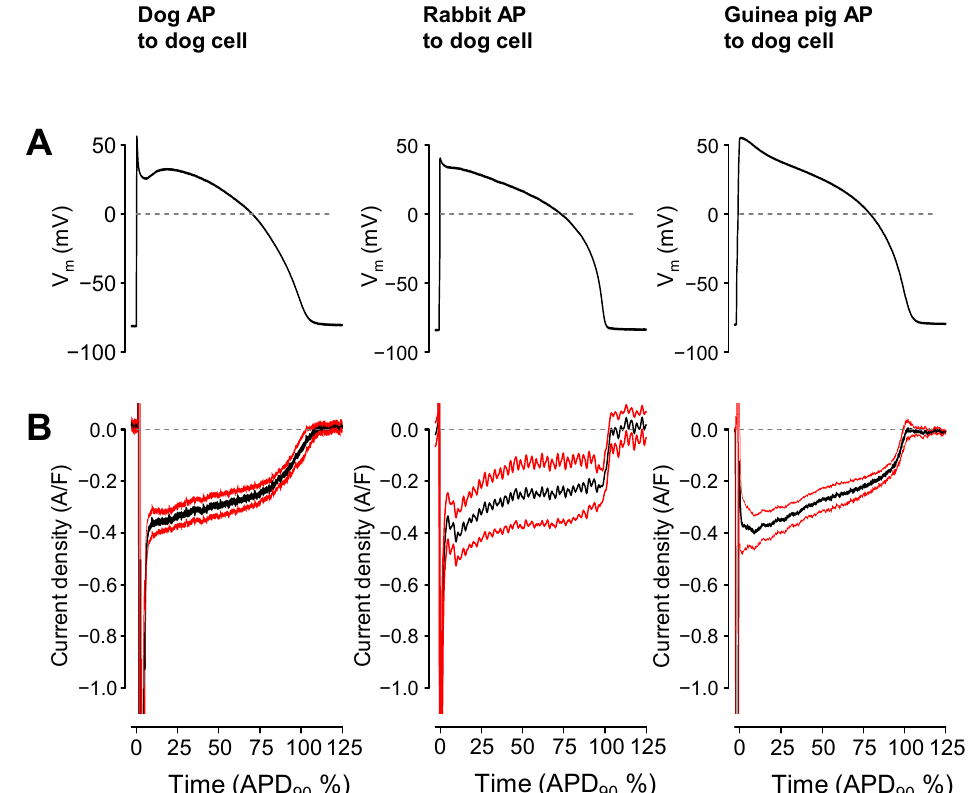
Figure 4. Effect of the shape of the command AP on the profile of I Na,late in the canine myocytes. Black lines are the mean data, while red ones represent the SEM values. ( A ) The canonic command APs are shown in the top row. ( B ) I Na,late profiles, averaged according to their positions on the time axis, where the action potential duration measured at 90% repolarization (APD 90 ) was considered as 100%.